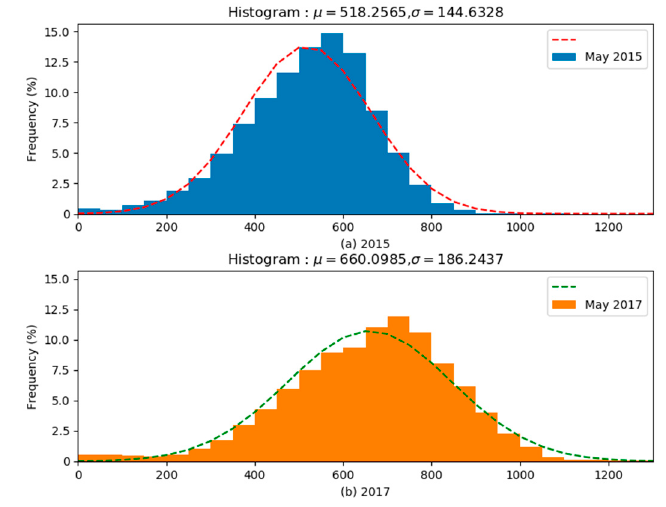
Figure 14. The average daily income of taxi drivers in ( a ) 2015 and ( b ) 2017.